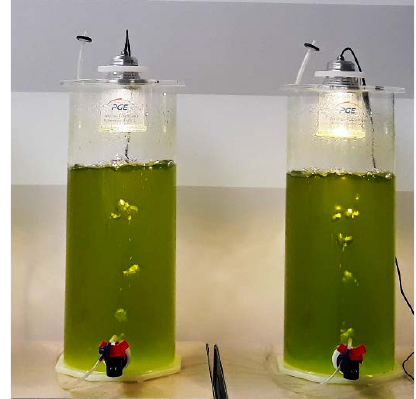
Figure 2. Experimental setup applied for research of Monoraphidium microalgae .